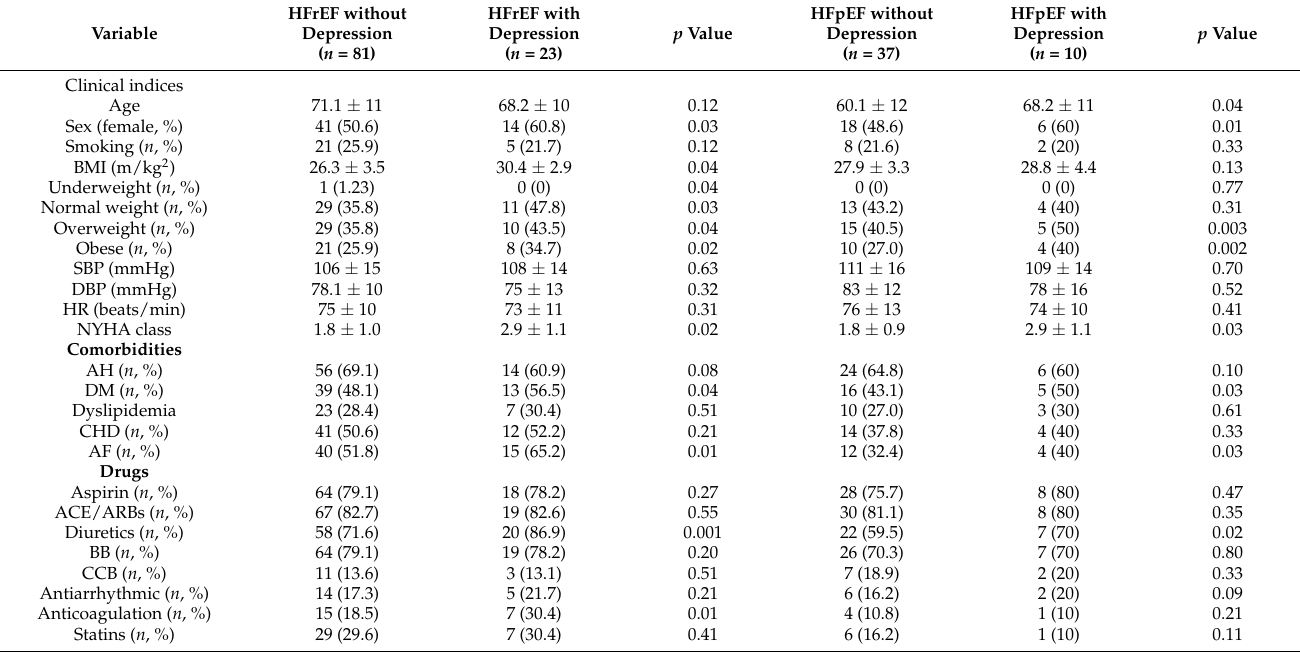
Table 1. Demographic and clinical data between HF patients with and without depression according to EF. Variable